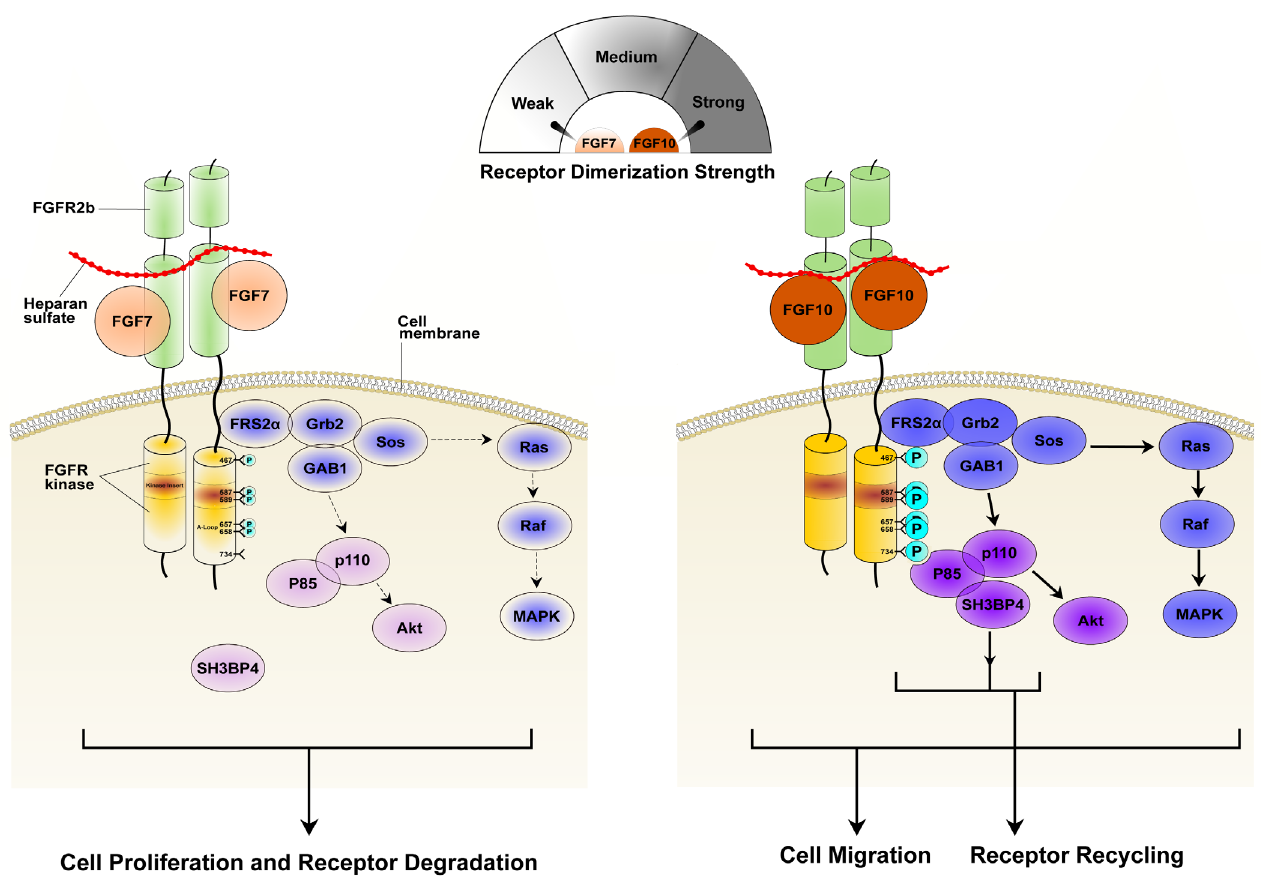
Figure 4. The “threshold model” can account for the activation of distinct pathways by FGF7 and FGF10 binding to FGFR2b. (Left) Relative to FGF10, FGF7 exhibits poor affinities for both FGFR2b and the heparan sulfate (HS) co-receptor and hence forms a weaker dimer with FGFR2b. Consequently, FGF7-FGFR2b dimers are less efficient in promoting transphosphorylation of A-loop tyrosines (necessary for kinase activation) and altogether fail to phosphorylate Y734 (necessary for the recruitment of distinct substrates and receptor recycling). Weaker kinase activation corresponds with a transient and overall weaker activation of MAPK that is further exacerbated by the inability of FGFR2b to recycle to the cell surface. (Right) FGF10 dimerizes its receptor strongly, promoting robust phosphorylation of A-loop tyrosines so as to transduce a prolonged signal. Y734 also becomes phosphorylated, thus enabling the recruitment of the P85-SH3BP4 complex in order to elicit receptor recycling and cell migration. Stronger receptor dimerization strength and higher signaling intensity and phosphorylation levels are indicated by darker coloring. A-loop, activation loop; FGF, fibroblast growth factor; FGFR, fibroblast growth factor receptor; MAPK, mitogen-activated protein kinase.